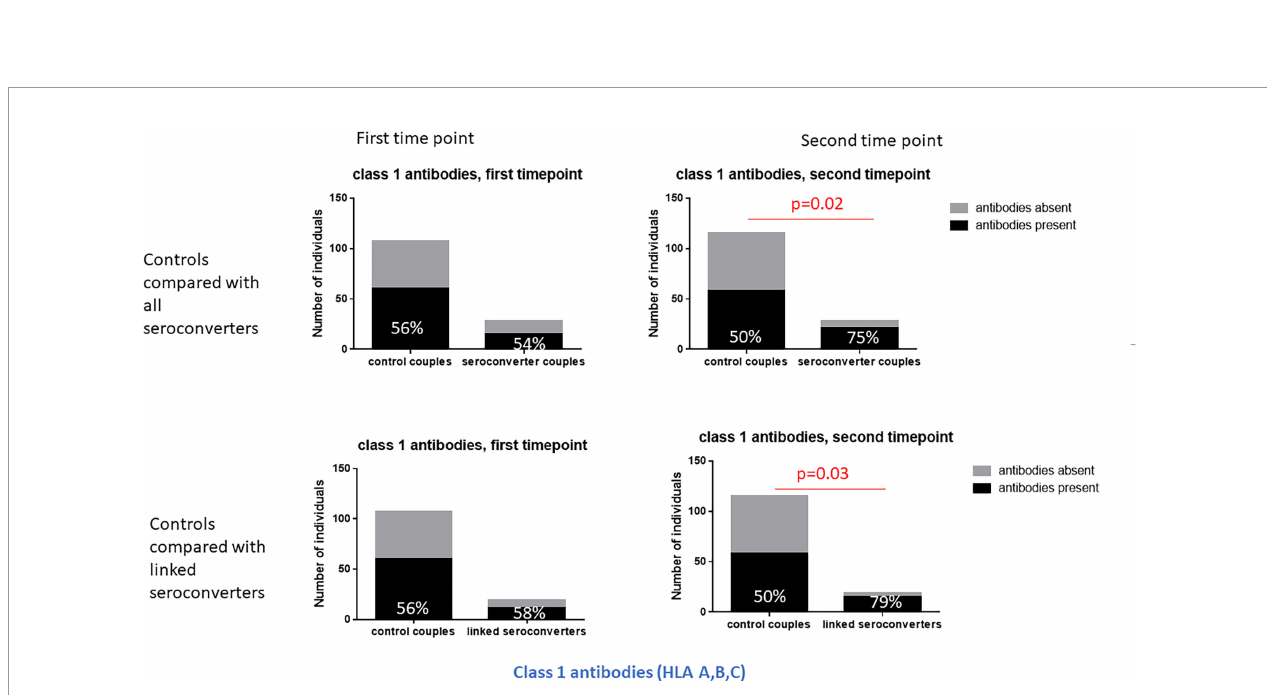
FIGURE 2 | Class 1 HLA antibodies in HIV-seroconverters compared with highly exposed persistently seronegative controls, at the fi rst and second timepoint. Upper panel shows comparison of highly exposed persistently seronegative controls with all HIV-seroconverter couples. Lower panel shows comparison of highly exposed persistently seronegative controls with only linked seroconverters. At the second timepoint, signi fi cantly more HIV-seroconverters ( all seroconverters or linked seroconverters) than highly exposed persistently seronegative controls expressed class 1 HLA